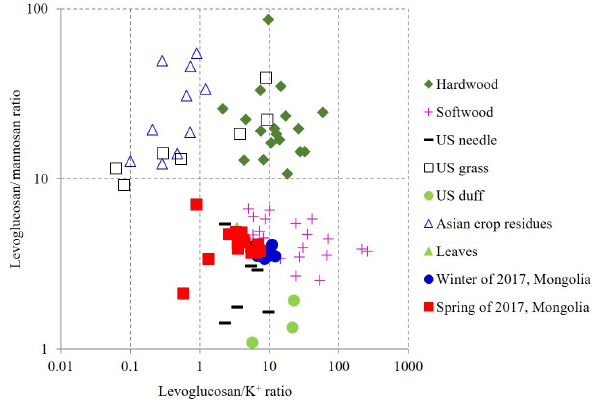
Figure 10. Scatter plot of levoglucosan / K + versus levoglu- cosan / mannosan from different types of BB emissions, including those measured in Ulaanbaatar (blue circles and red